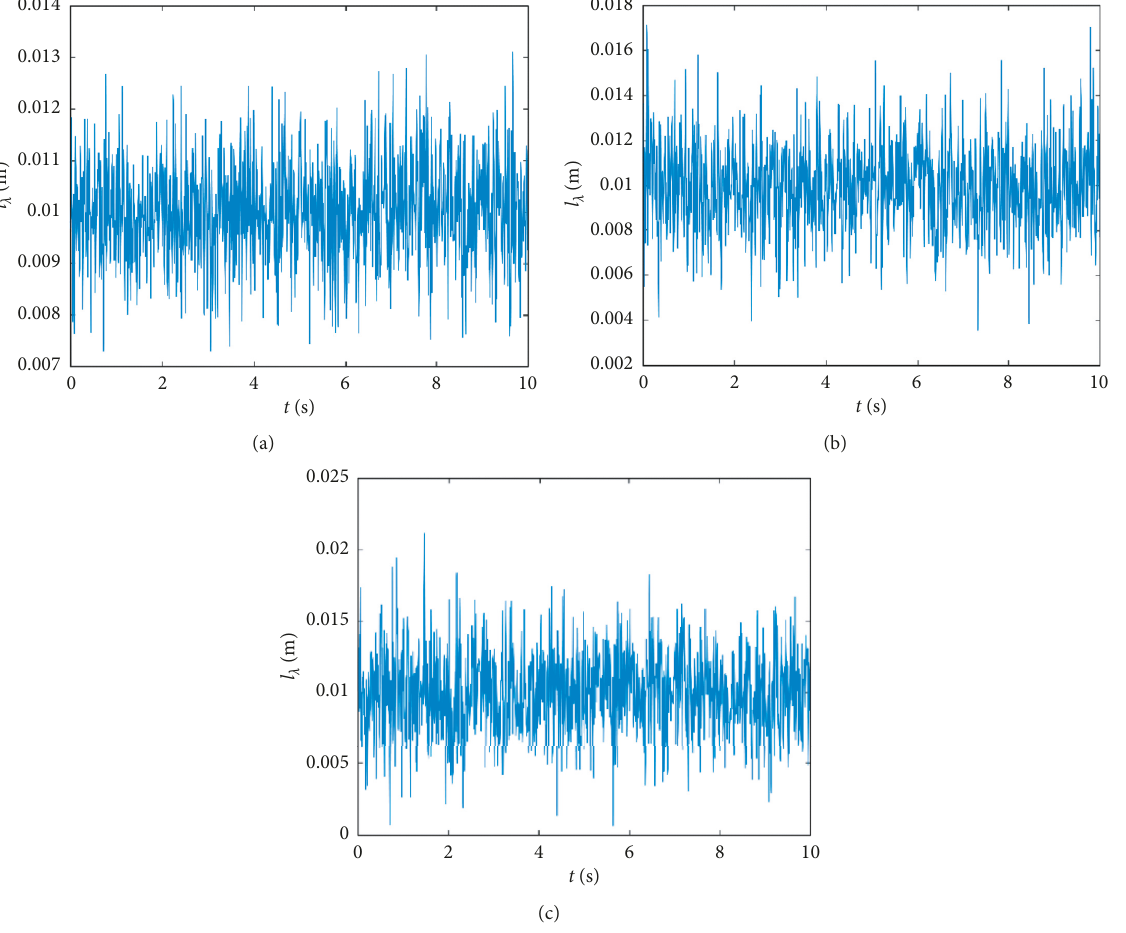
Figure 3: Normally distributed random contact line length. (a) μ � 0 . 01 m , σ � 0 . 001 m. (b) μ � 0 . 01 m , σ � 0 . 002 m. (c) μ � 0 . 01m , σ � 0 . 003 m.